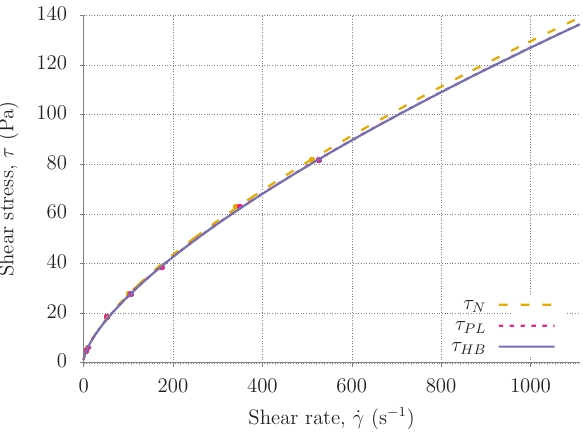
Figure 10: Friction pressure gradients calculated for steady axial flow of the fluid flow curves in Figure 7 in the concentric annulus be- tween a 9 5 ⁄ 8 ” casing and a 12 1 ⁄ 4 ” diameter wellbore. The pressure gradients are obtained for Herschel-Bulkley parametrizations based on different wall shear rate